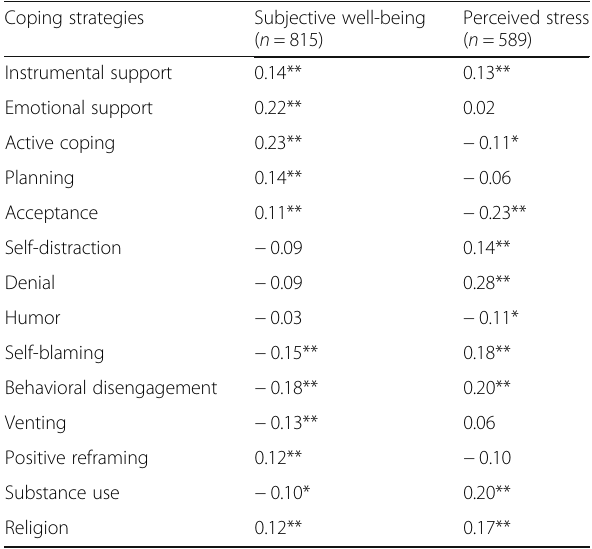
Table 7 Correlations of coping strategies with subjective well- being and perceived stress Coping strategies Subjective well-being ( n =